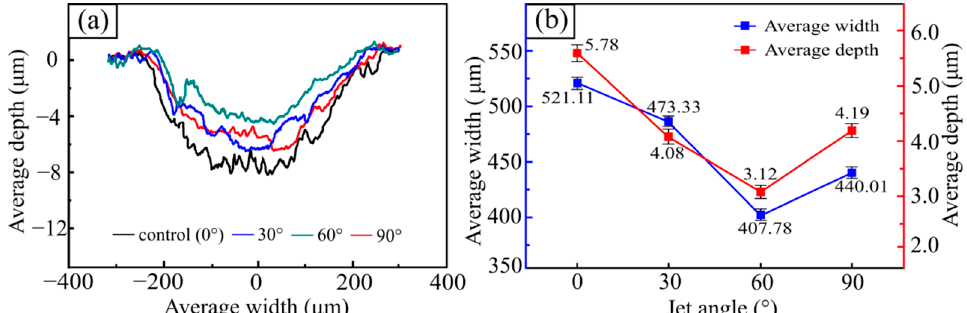
Figure 10. Two-dimensional morphology of wear masks: ( a ) wear mark section profile versus jet angle; ( b ) average wear depth and width versus jet angle.